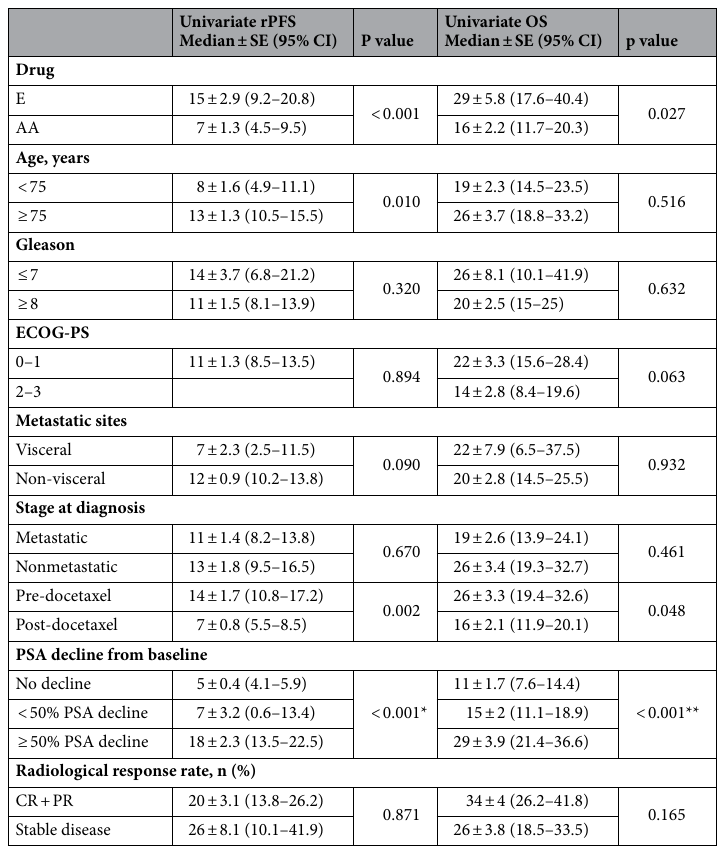
Table 3. Univariate analysis of rPFS and OS in all patient population. SE standard error, CI confidence interval, E enzalutamide, AA abiraterone acetate, PSA prostate-specific antigen, ECOG-PS Eastern Cooperative Oncology Group-Performance Status, rPFS radiological progression free survival, OS overall survival, CR complete remission, PR partial remission. *There was a significant difference between No decline vs. < 50% PSA decline, No decline vs. > 50% PSA decline, and < 50% PSA decline vs. > 50% PSA decline. **There was a significant difference between No decline vs. > 50% PSA decline, < 50% PSA decline vs. > 50% PSA decline, but no significant difference between No decline vs. < 50% PSA